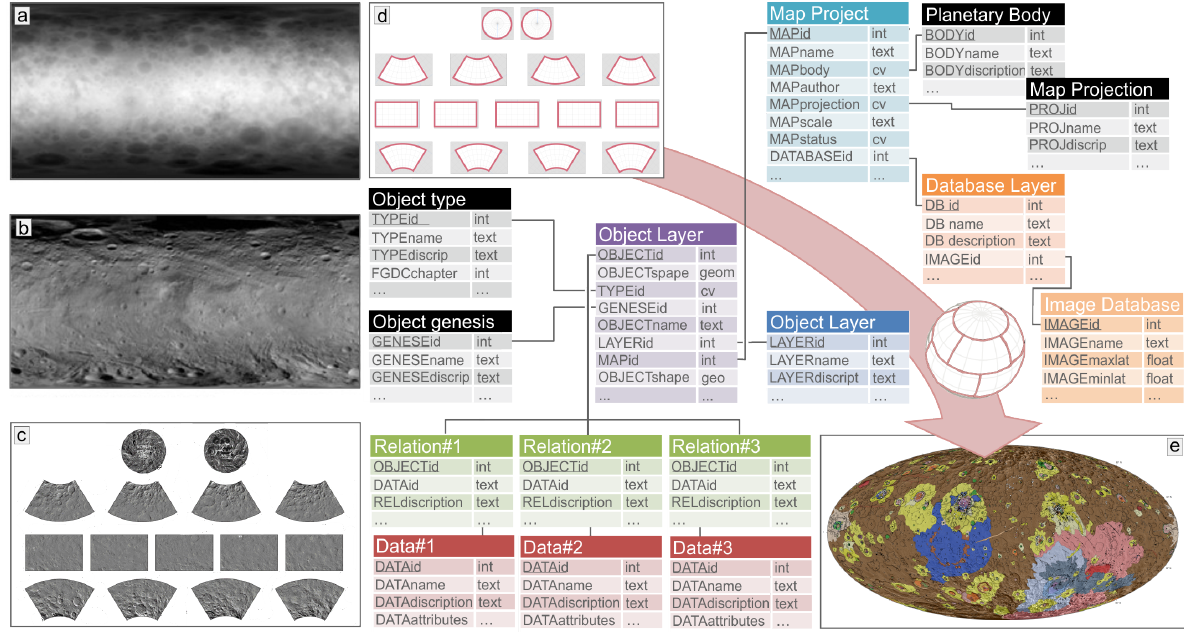
Figure 2. Different datasets serving as basis for developing the prototype. ( a ) Ceres Dawn FC2 HAMO global DTM, ( b ) Ceres Dawn FC2 HAMO global mosaic, ( c ) schema for HAMO map quadrangle, ( d ) quadrangle for geological maps, and ( e ) unified global map dataset of Ceres geology (references are indicated in the text below; coloured data tables describe the data model for the GIS-related data merge and linked to